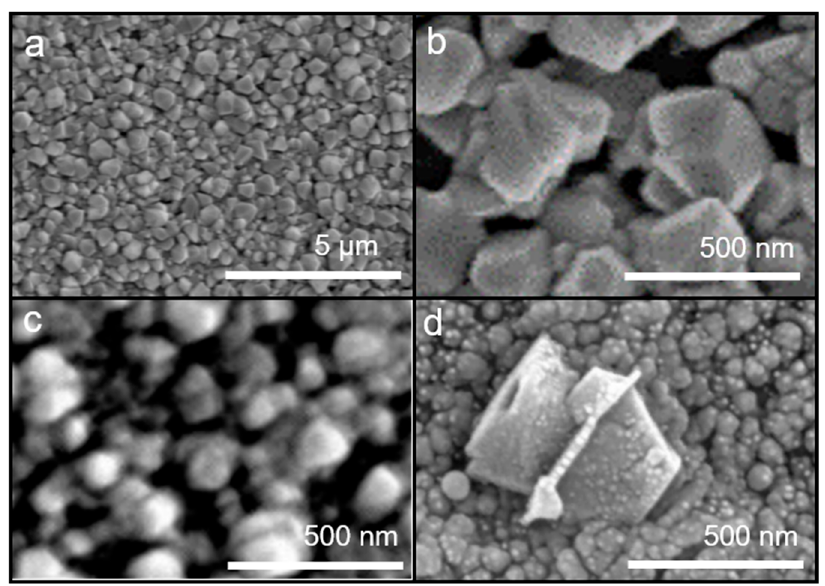
Figure 2. SEM images of ZnO coatings prepared using ultrasonic spray pyrolysis at ( a ) 450 °C, ( b ) 400 °C, ( c ) 350 °C, and ( d ) 300 °C.